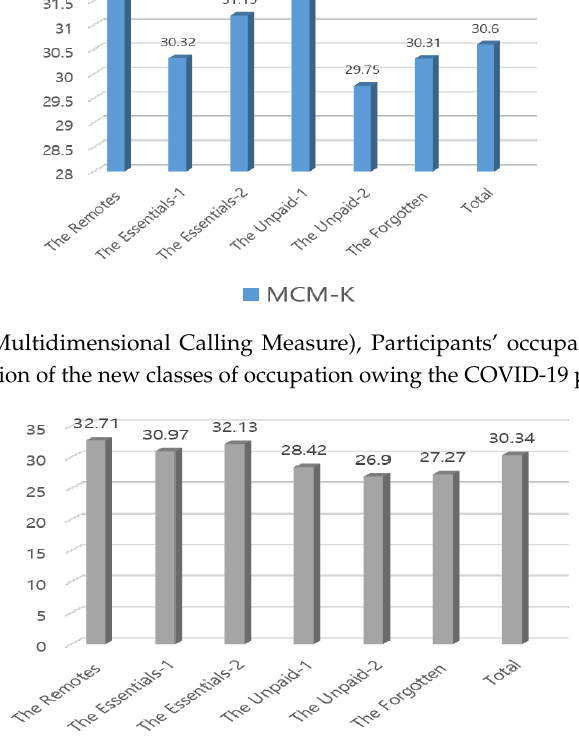
Figure 2. CASP-19 (Control, Autonomy, Self-realization, and Pleasure), Participants’ quality of life by our Korean-adapted version of the new classes of occupation owing the COVID-19 pandemic.